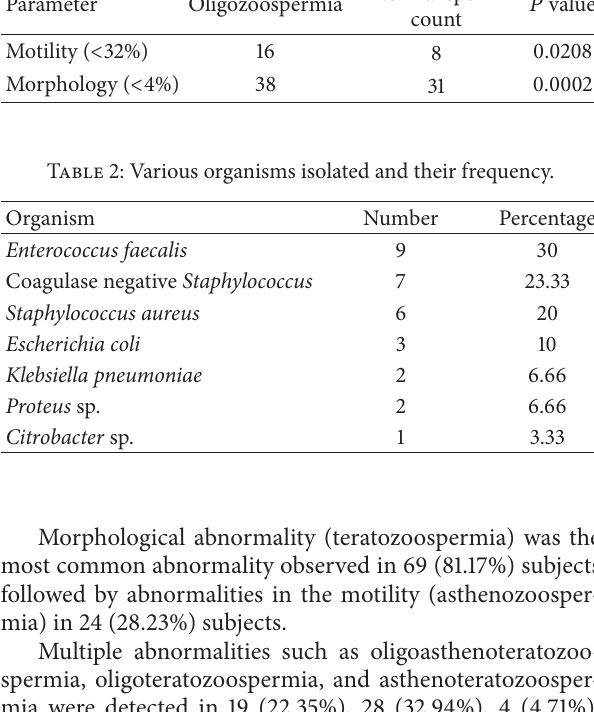
Table 1: Comparison of abnormal semen parameters between individuals with normal sperm count and oligozoospermia.